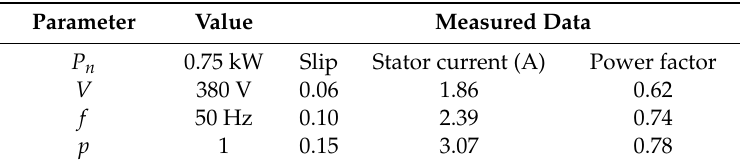
Table 17. Data of Machine 4 and measured data: three-phase induction motor [45].